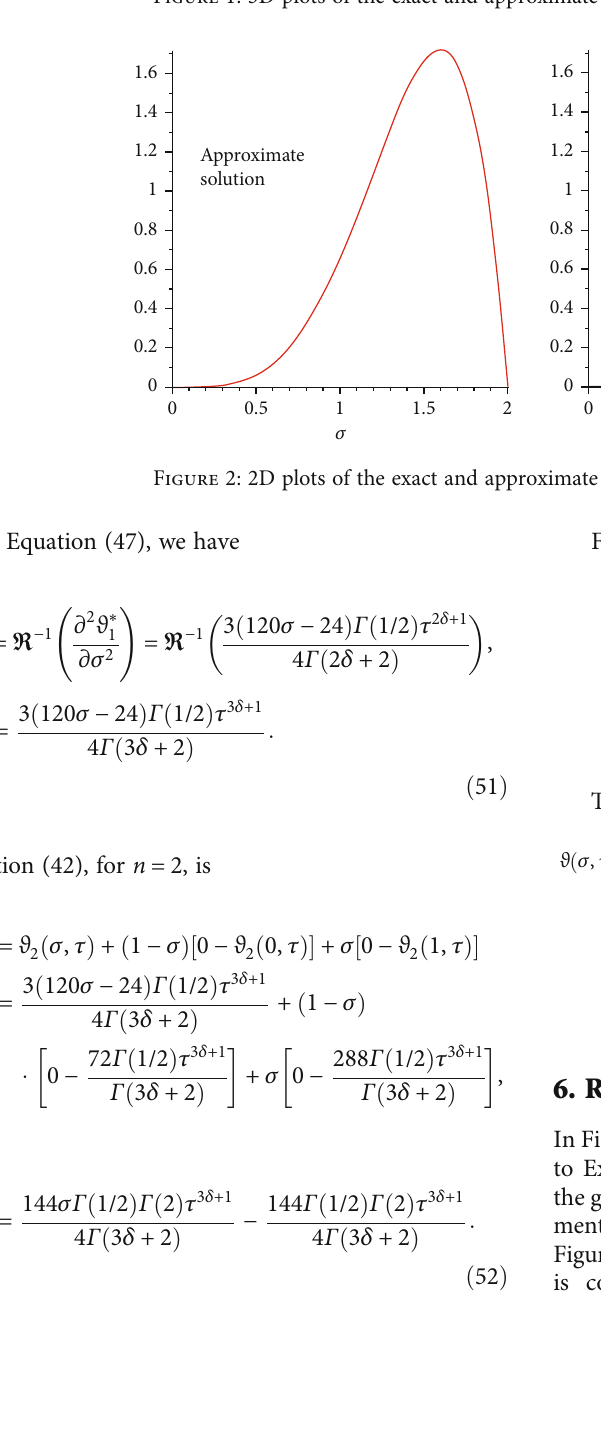
Figure 1: 3D plots of the exact and approximate solution for δ = 1 of Example 5.1.